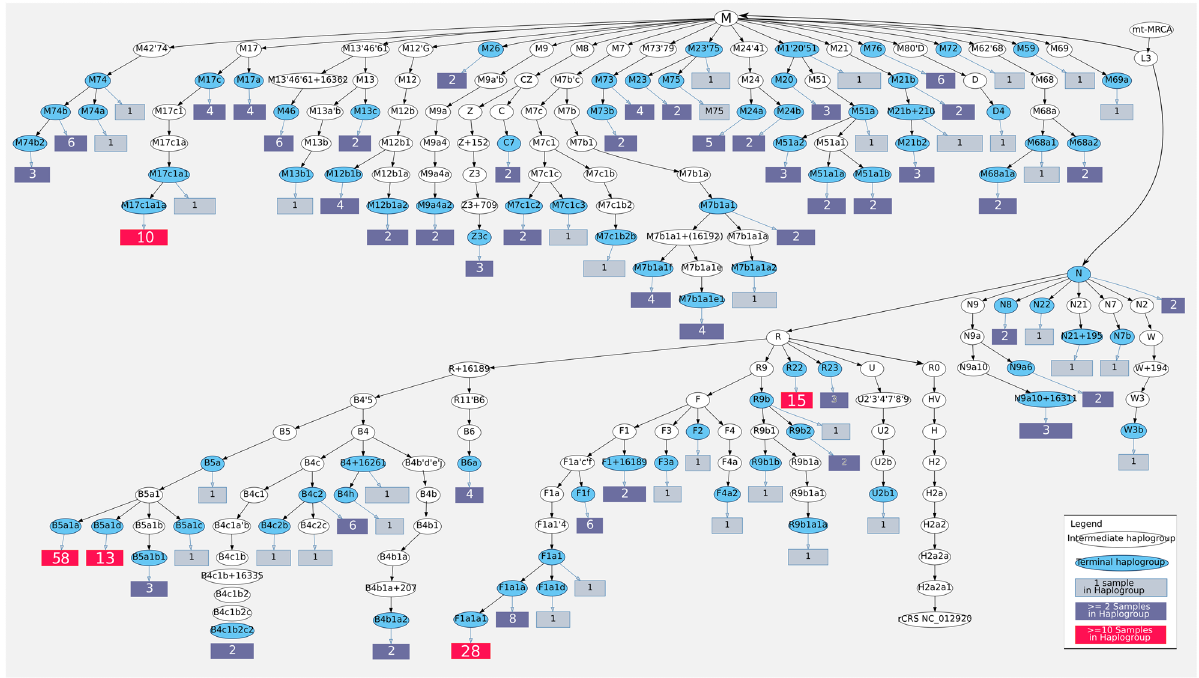
Figure 2. Phylogenetic representation of 299 Cambodian mtDNA samples, representing 224 unique haplotypes, classified into 90 distinct haplogroups. Haplogroups can be terminal (blue oval shaped) or intermediate nodes (white oval shaped), while rectangles indicate the numbers of samples under the corresponding haplogroup, with colour-coding according to the number of samples, as indicated in the legend at the bottom left. Figure generated with HaploGrep 2 “lineage” feature generating a DOT file, visualized with Graphviz and adapted in